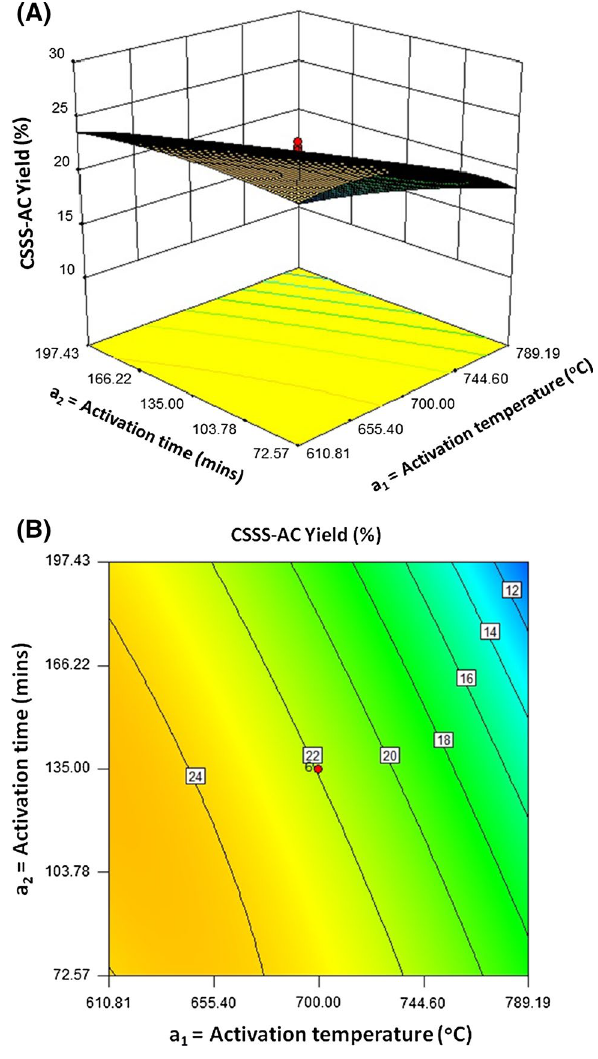
Fig. 5 Response surface plots of CSSS-AC yield; a 3D response sur- face plots demonstrating the effect of temperature and time of activa- tion (IR = 1.60) and b contour plots effect of the same variables on the CSSS-AC yield response (Y CSSS )